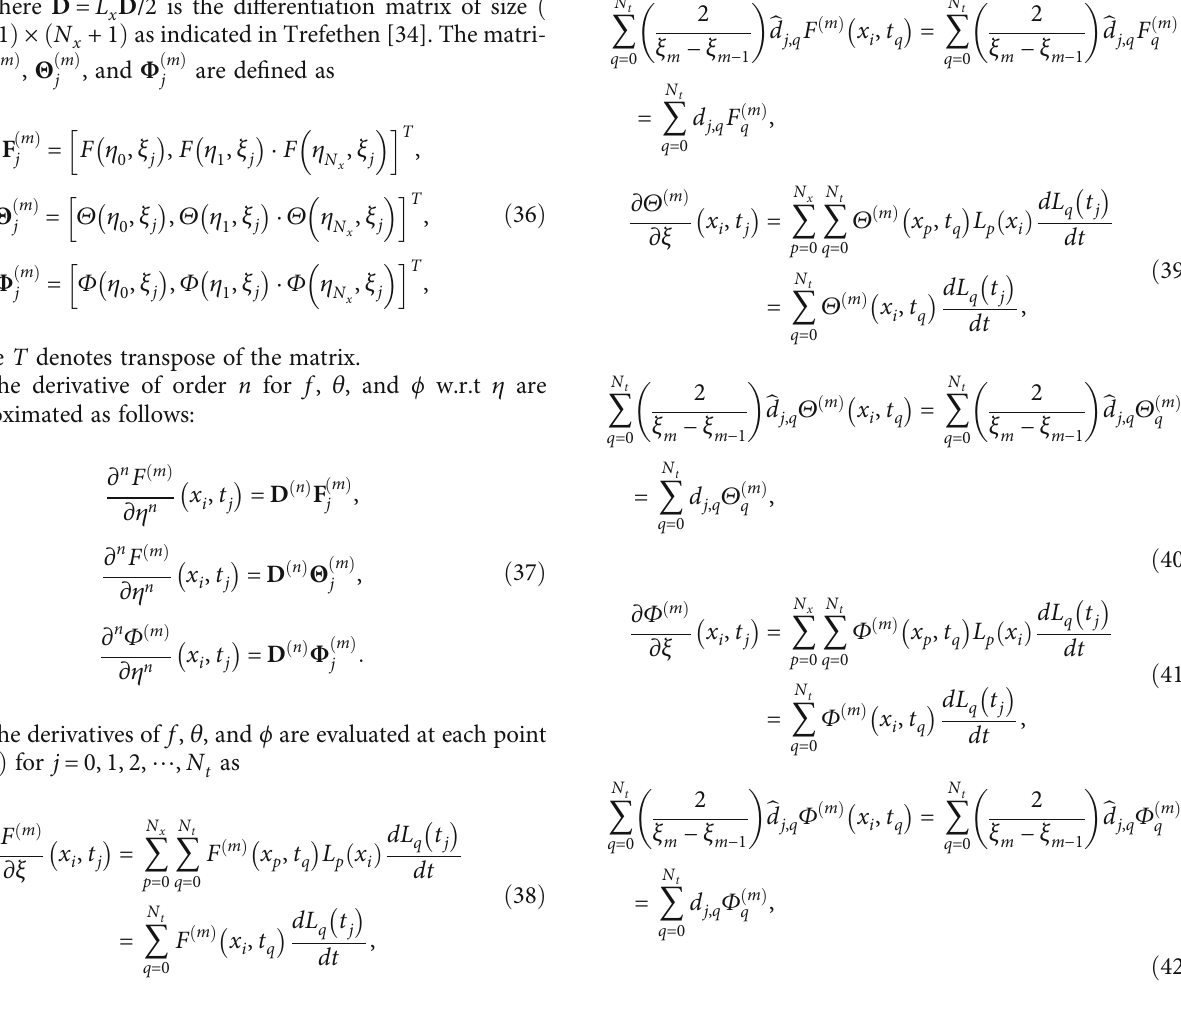
De = 0 : 1, N = 0 : 5, n = 0 : 5, f t when